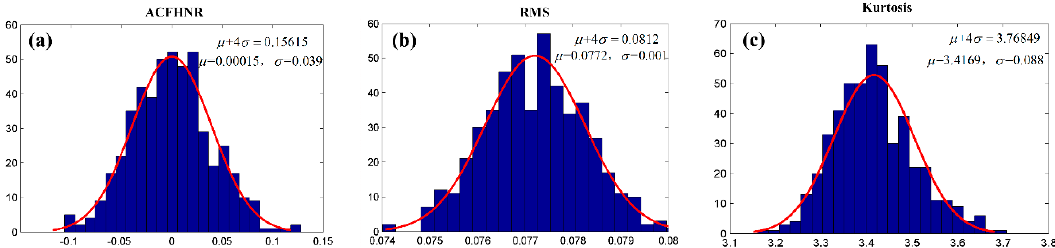
Figure 19. ( a ) The RMS value for the full life cycle of bearing 1; ( b ) The sensitivity value of RMS.